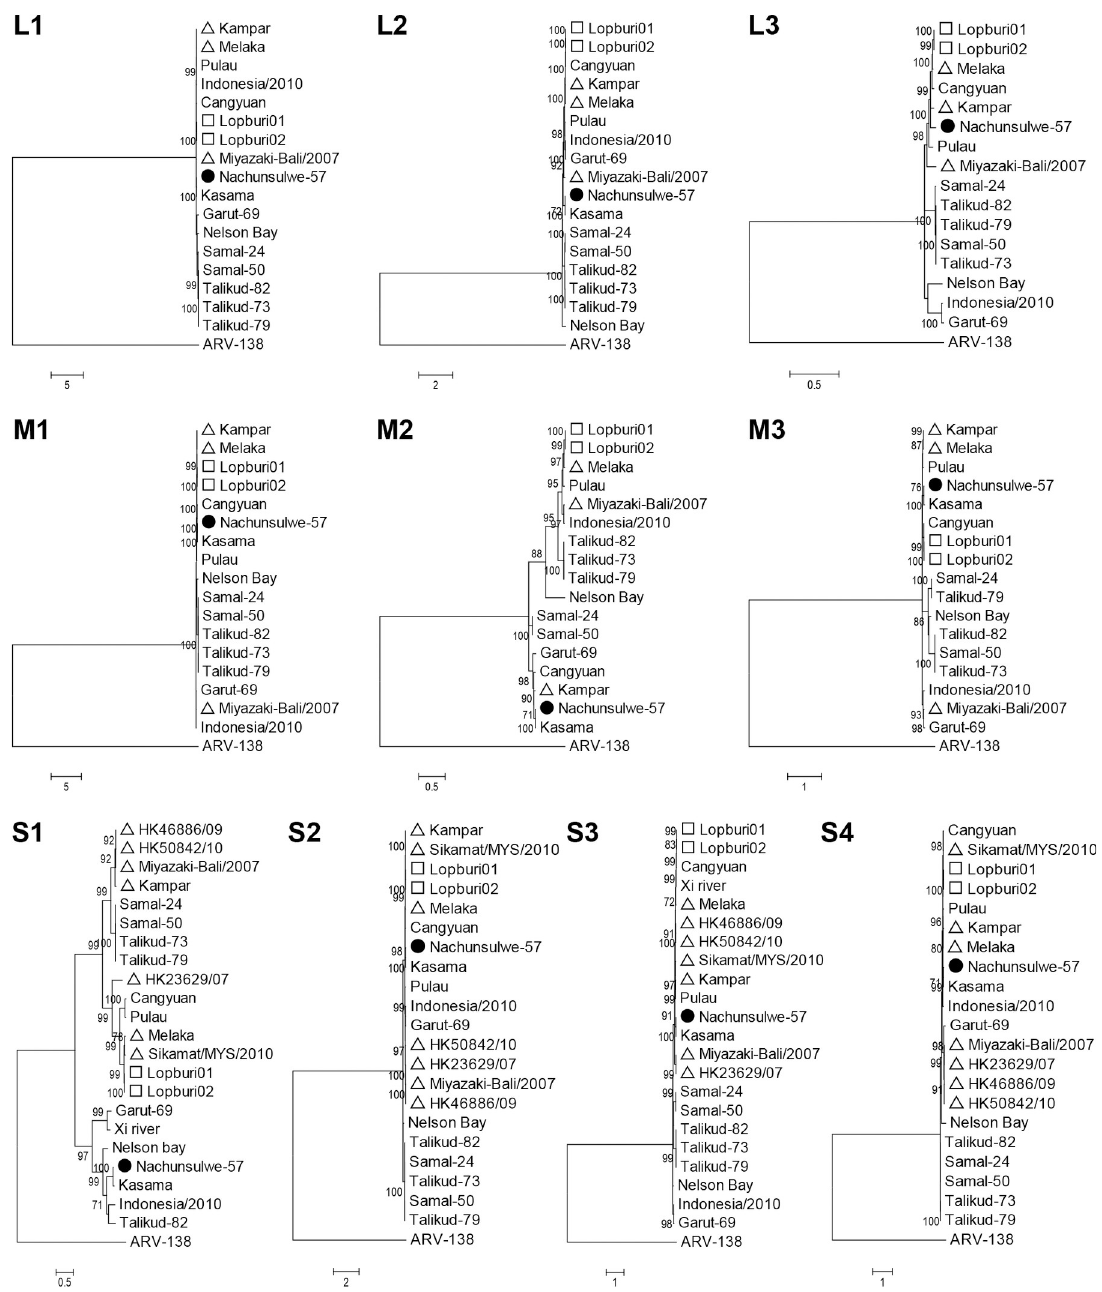
Fig 2. Phylogenetic analysis of 10 viral genome segments of PRV, including Nachunsulwe-57. Phylogenetic trees based on the nucleotide sequence of the complete L1-L3, M1-M3, and S1-S4 segments were constructed using the maximum likelihood method with 1,000 bootstrap replicates. The specie of Avian orthoreovirus was included as the outer group. Bootstrap values greater than 70% are shown on the interior branch nodes, and scale bars indicate the number of substitutions per site. Black circles represent the isolated PRV, Nachunsulwe-57. The triangles and squares represent PRV strains identified in humans and monkeys, respectively, while the other PRV strains were identified in bats. The Kasama strain was not included in the phylogenetic tree of L3 segment because the complete sequence of the Kasama strain L3 segment could not be obtained. Abbreviation: ARV-138, Avian orthoreovirus strain 138.